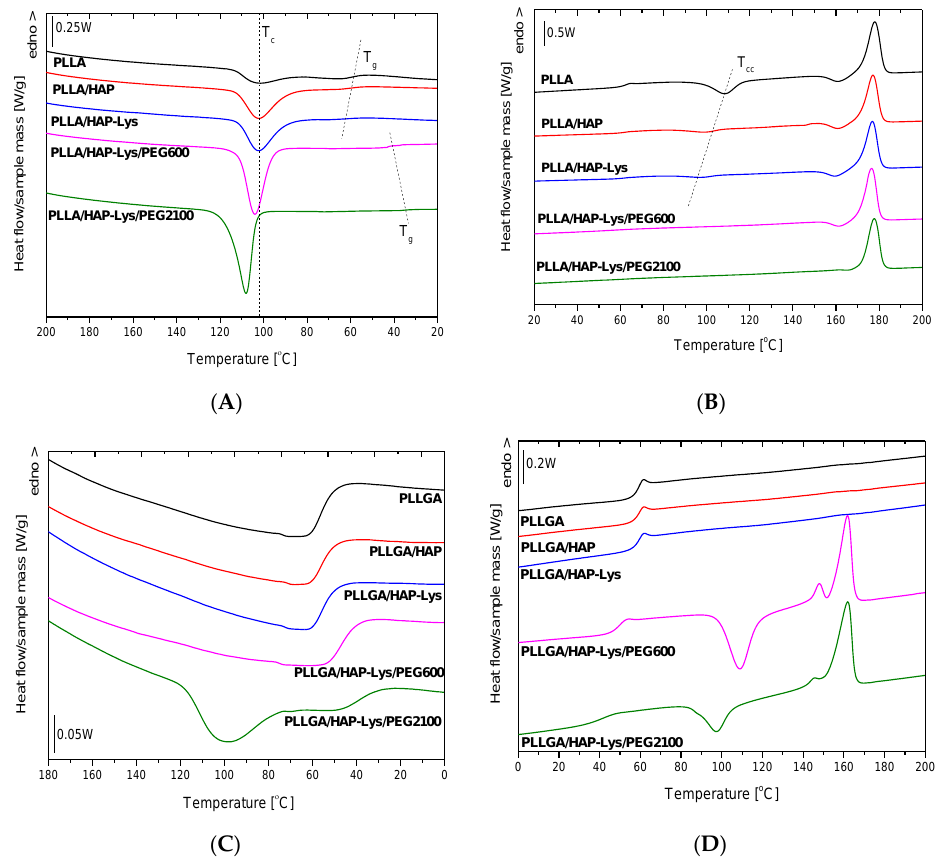
Figure 6. The cooling and second heating DSC curves of ( A , B ) PLLA and PLLA-based composites and ( C , D ) PLLGA and PLLGA-based composites.